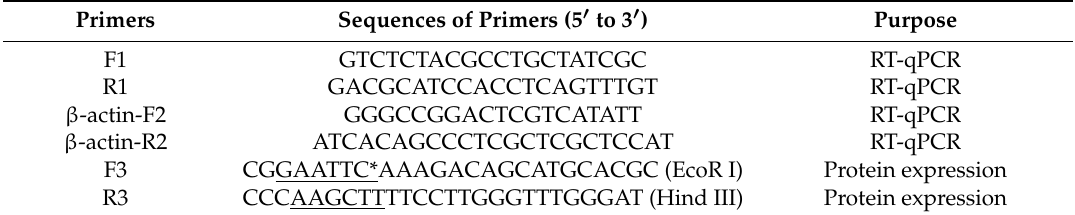
Table 1. Primers used in